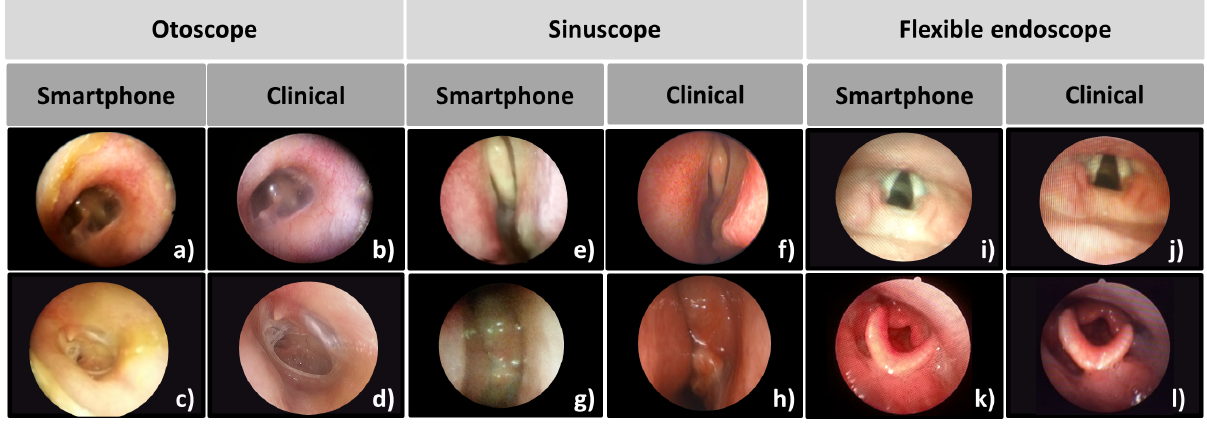
Figure 6. Result of human in-vivo imaging at Otolaryngology. Otoscope, sinuscope, and flexible endoscope were utilized. The corresponding sites were captured with smartphone-based endoscope and commercial endoscope system in clinical settings. (a, b) normal tympanic membrane. (c, d) chronic otitis media, central large perforation. (e, f) normal middle turbinate. (g, h) chronic rhinosinusitis with nasal polyp. (i,j) normal vocal cord. (k,l) postoperative state of thyroid cancer surgery in